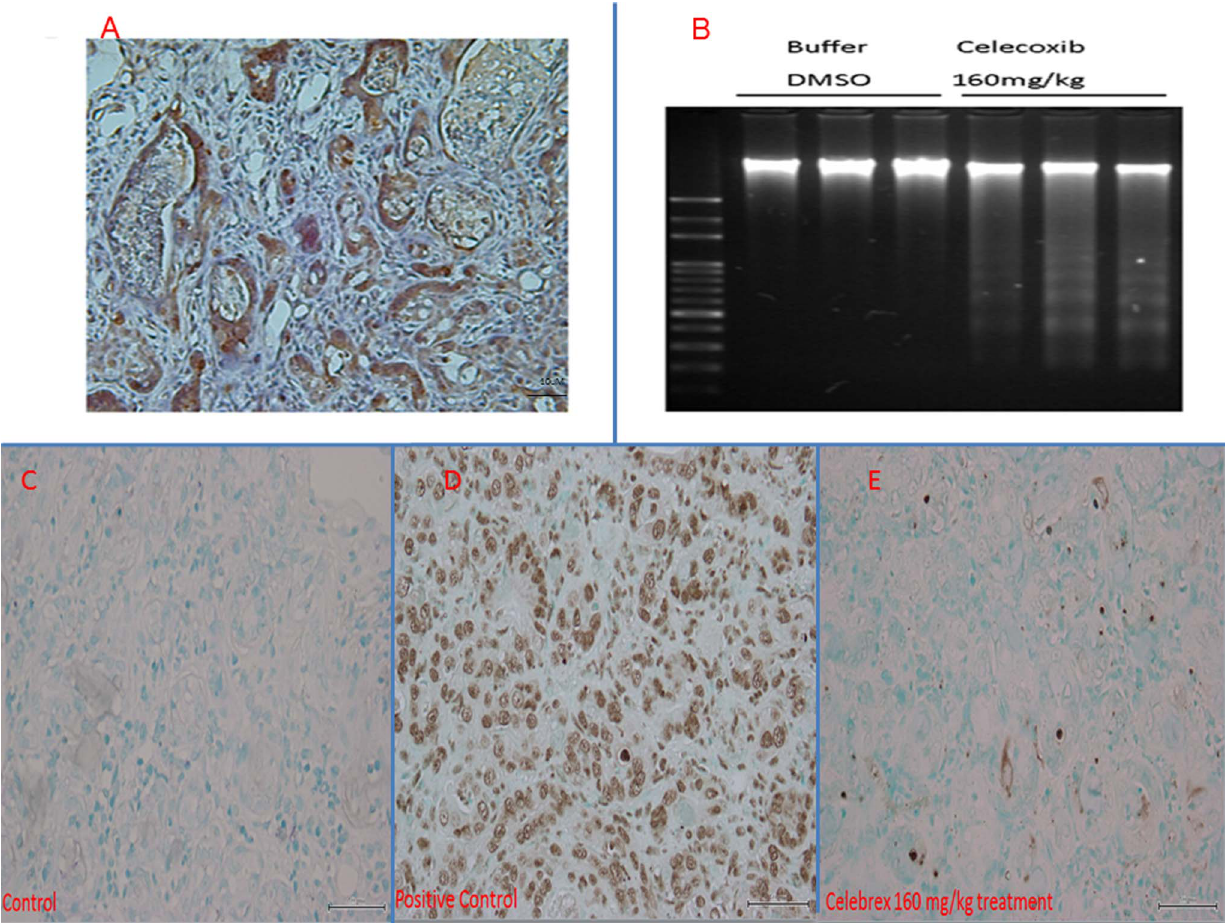
Figure 5. COX-2 expression in rat CCA and apoptosis detection in treated rat CCA. (A) Rat CCA tissue revealed positive cytoplasmic immunoreactivity for COX-2 ( 6 400). (B) Apoptotic DNA fragmentation of rat CCA tissue after treatment with celecoxib (160 mg/kg body weight) for 5 weeks visualised by the DNA laddering assay. No apoptotic DNA fragmentation was observed in the control group treated with DMSO buffer for 5 weeks. (C, D, E) TUNNEL assay for determination of rat CCA apoptosis. The positive cells for TUNNEL assay with brown stains are shown in the positive control (TACS-Nuclease treated tissues ) figure (D). No apoptosis was detected in the control group (C). (E) Apoptosis cells were detected in rat CCA tissues treated with celecoxib (160 mg/kg body weight). doi:10.1371/journal.pone.0069928.g005 assay results for rat CCA tissues (Figure 5C, D, and E). Although the use of celecoxib for chemoprevention induces severe cardio- vascular side effects [18,46,47], during the experimental period, no obvious observable side effects were noted in the treated rats.